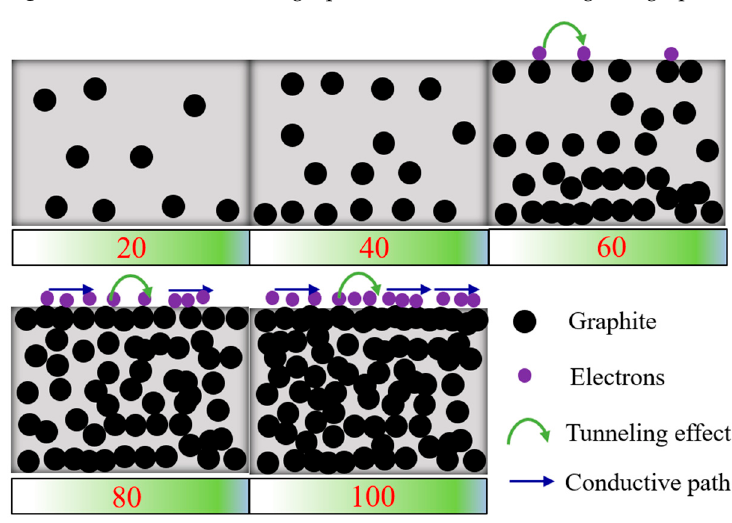
Figure 9. Schematic diagram showing the conductive mechanism of the